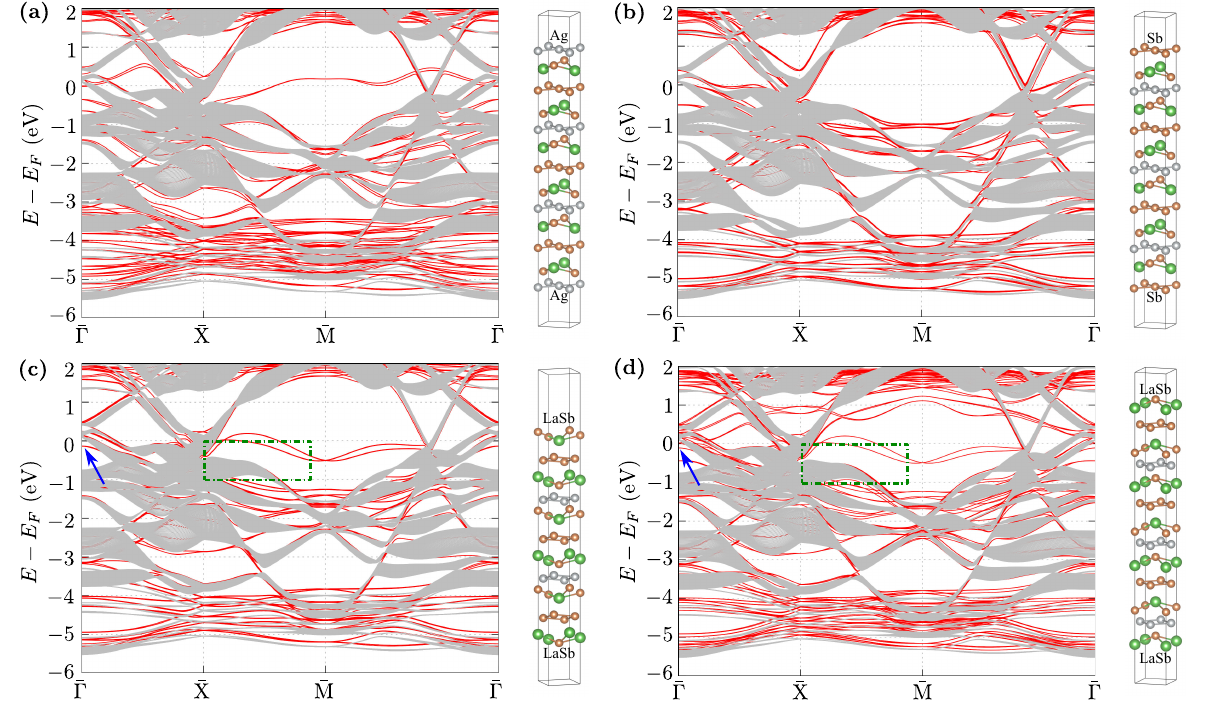
Figure 7. Band structures in slab geometry (with corresponding structures presented on right-hand side) dependent on the surface termination of Ag ( a ) and Sb ( b ) square nets and two possible terminations of the LaSb layer—conserving ( c ) and breaking ( d ) glide symmetry. Red lines denote the slab band structure from the DFT calculations, while gray lines denote the projected bulk band structure from tight binding models calculations (for eighty k z different momenta). Blue arrows indicate the surface states below the Fermi level at the Γ point. The green dotted-dashed line in ( c , d ) shows the area presented in Figure 8.